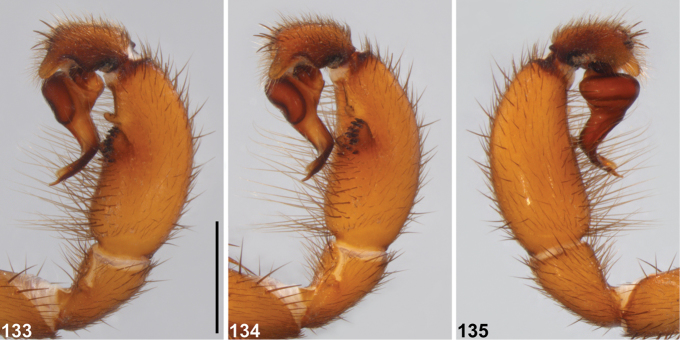

Idiosoma
dandaragan sp. n., male holotype (WAM T139522) from S. of Moora (Western Australia; JAF), pedipalp. 133 Retrolateral view 134 Retroventral view 135 Prolateral view. Scale bar 2.0.